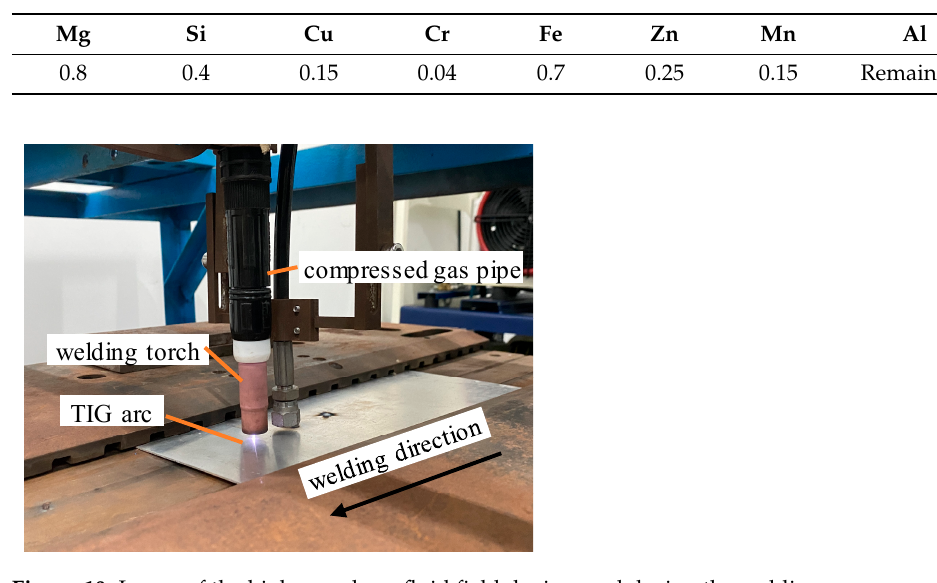
Table 3. Chemical compositions of the LY12, wt.%.